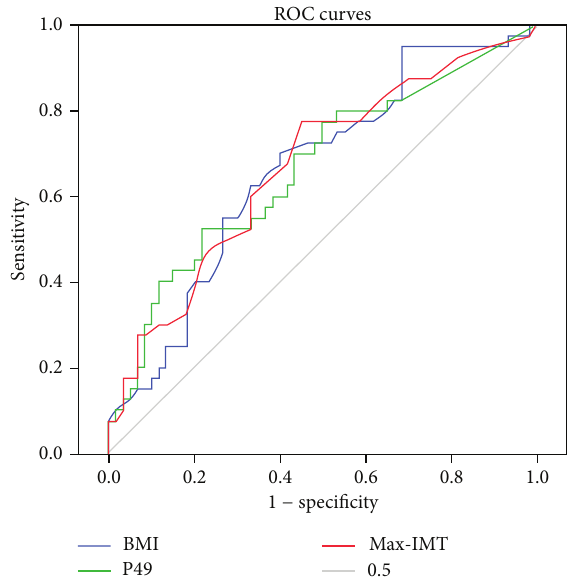
Figure 4: Receiver operating characteristic (ROC) curves. Areas under the curves (AUCs) in BMI, max-IMT, and intensity of P49 were 0.66, 0.67, and 0.67,